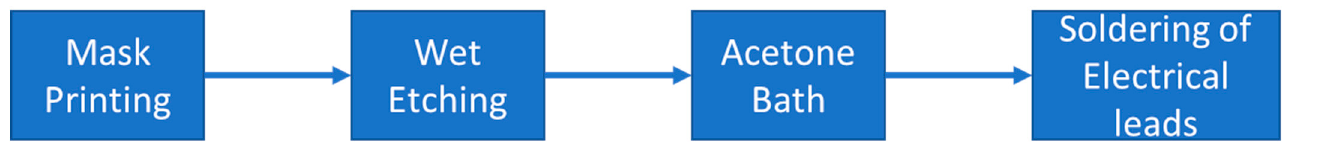
Figure 5. Stepwise fabrication process of elliptical planar inductors.